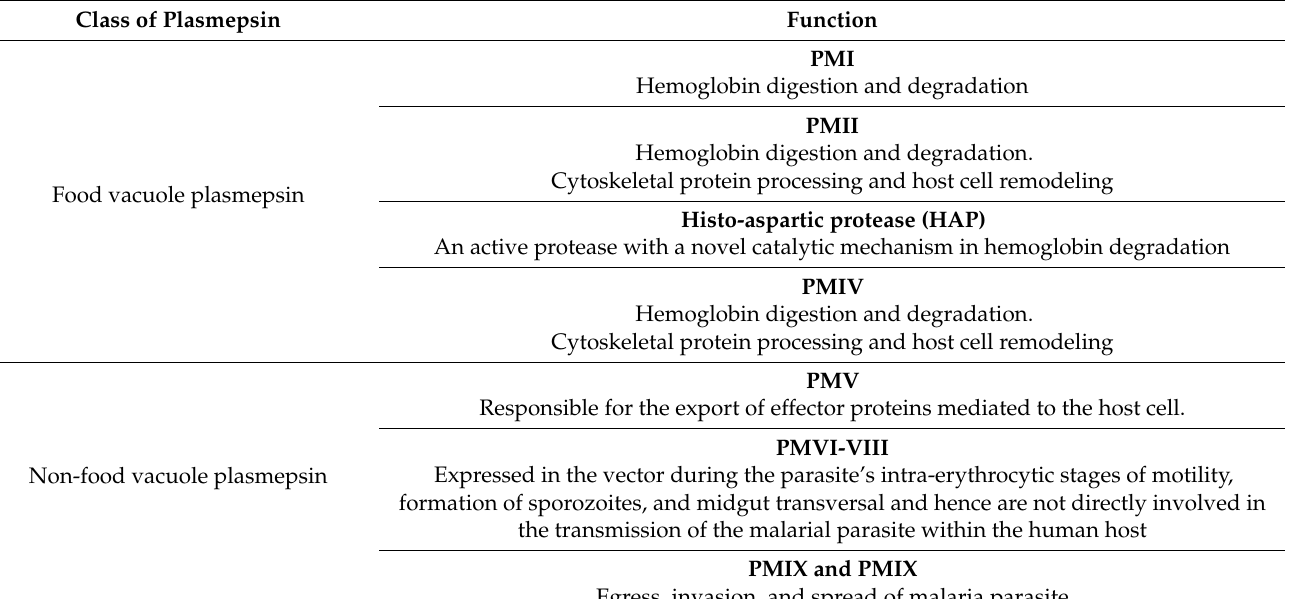
Table 3. Role of the classes of plasmepsins in malaria